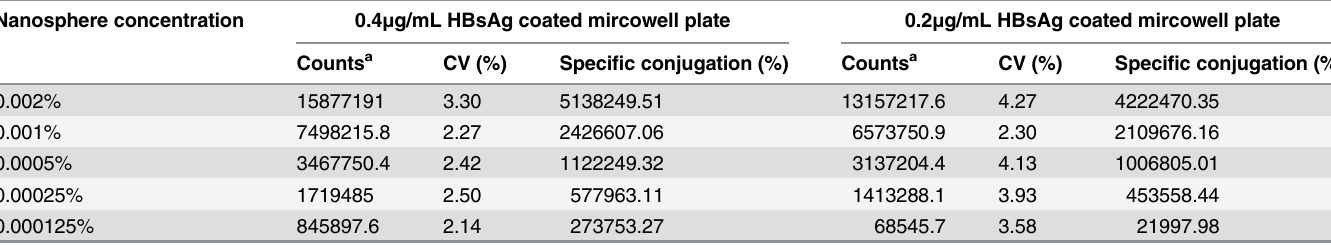
Table 2. Specific conjugation of antibody labeled BC-EDTA/Eu 3+ -nanosphere to HBsAg coated mircowell plate. Nanosphere concentration